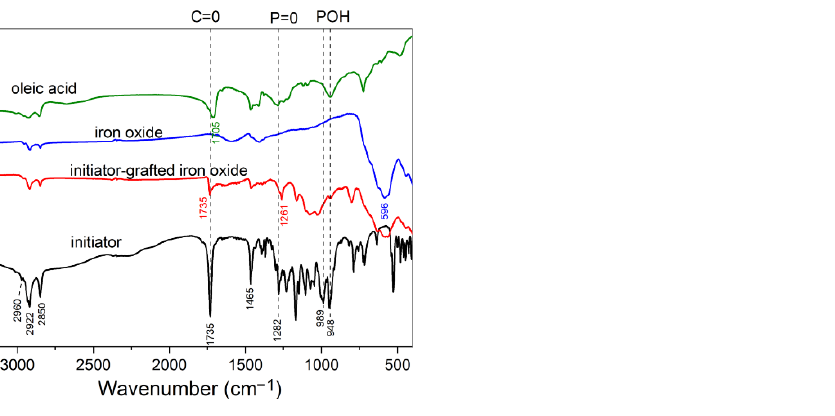
Figure 5. FTIR spectrum of initiator-modified iron oxide (red), compared to spectra of oleic acid (green), iron oxide (blue), and initiator (black).